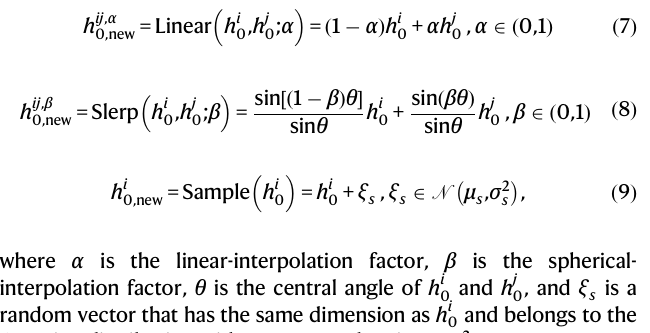
Fig.8|RI-962amelioratesTNF α -inducedSIRS. C57BL/6femalemice( n =14)were treated with vehicle, RI-962 (40mg/kg), or GSK3145095 (40mg/kg) via intraper- itoneal injection for 15min followed by the tail vein injection of mouse TNF α (300 μ g/kg). At 6h after TNF α injection, four mice in each group were killed at random, and the serums, hearts, livers, spleens, lungs, and kidneys were collected foranalysis. a Survivalratesofthemicetreatedwithvehicle( n =10),RI-962( n =10), andGSK3145095( n =10)afterTNF α injection.*** p -value<0.001byGehan-Breslow-